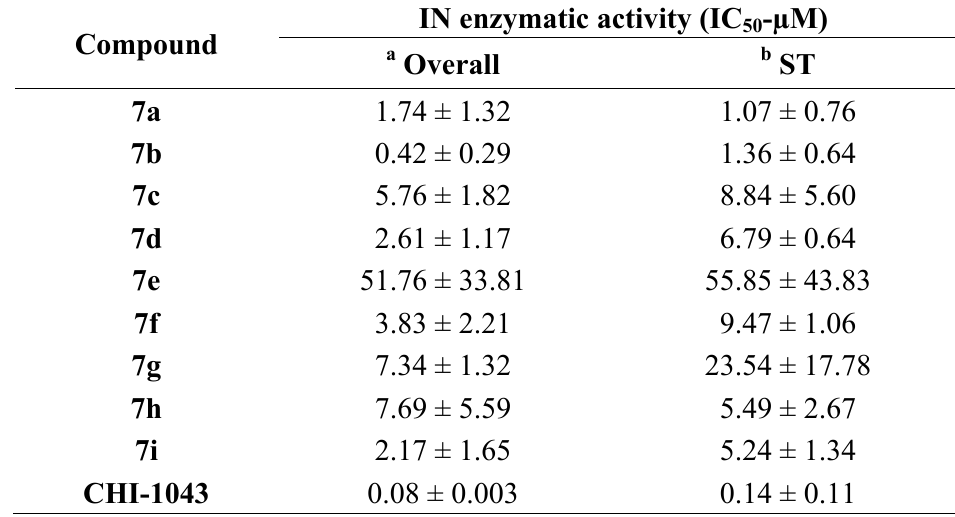
Table 1. Inhibition of HIV-1 integrase enzymatic